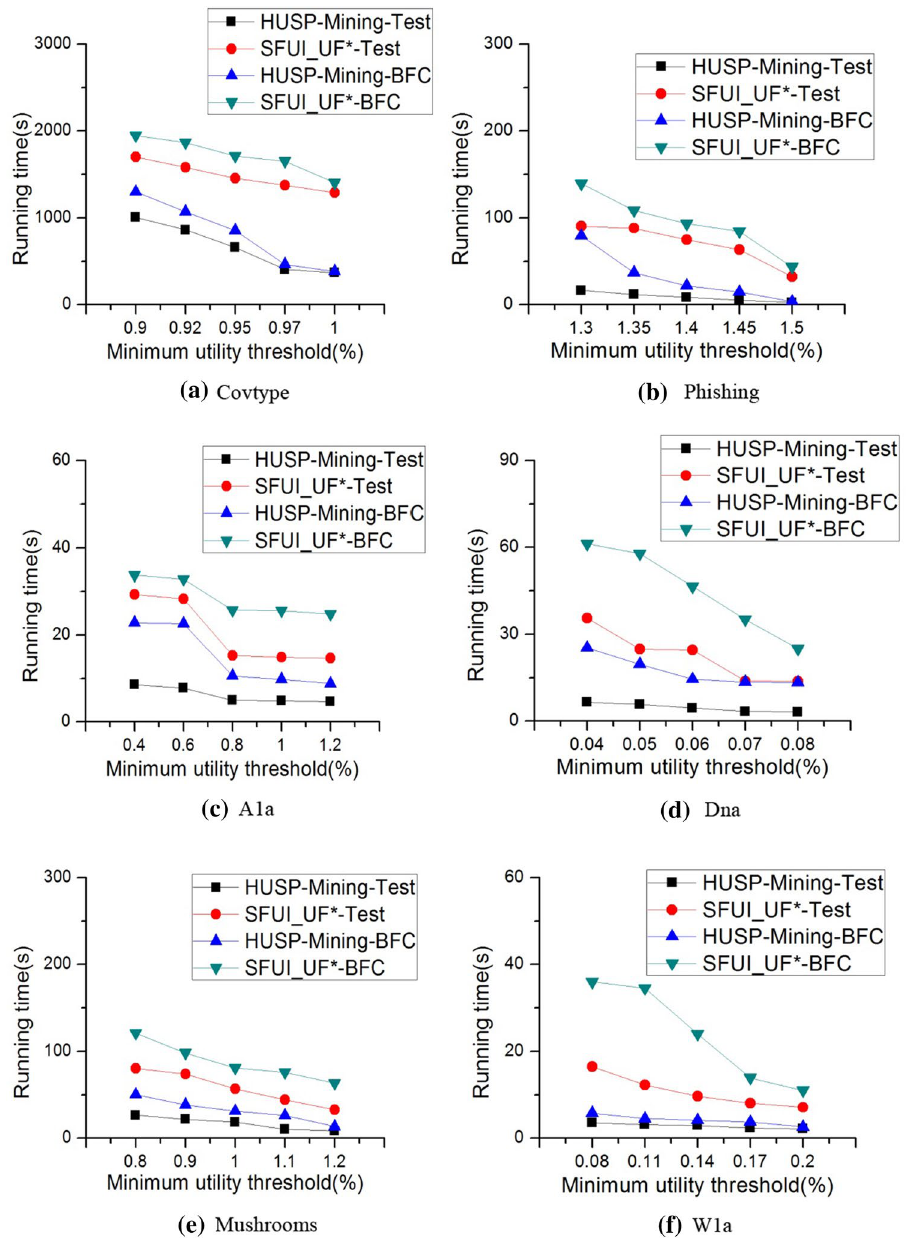
Fig. 11 Running time